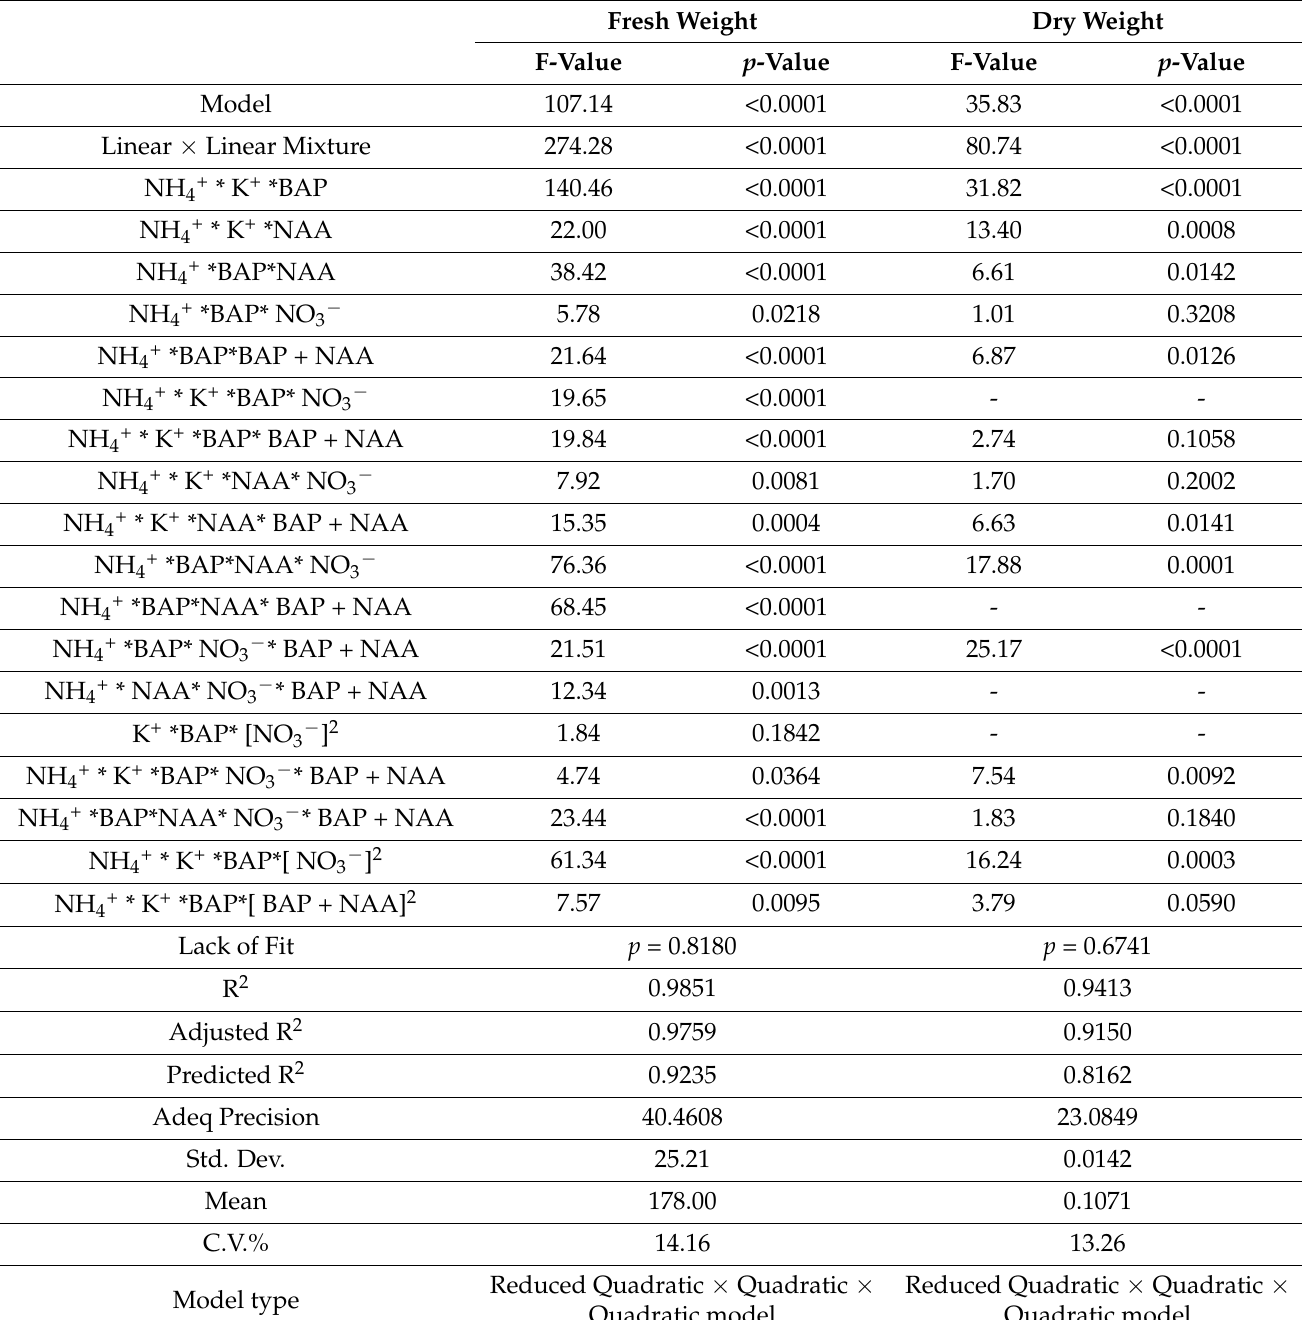
Table 1. ANOVA and summary statistics for the % fresh weight increase and dry weights of callus culture of R. rosea